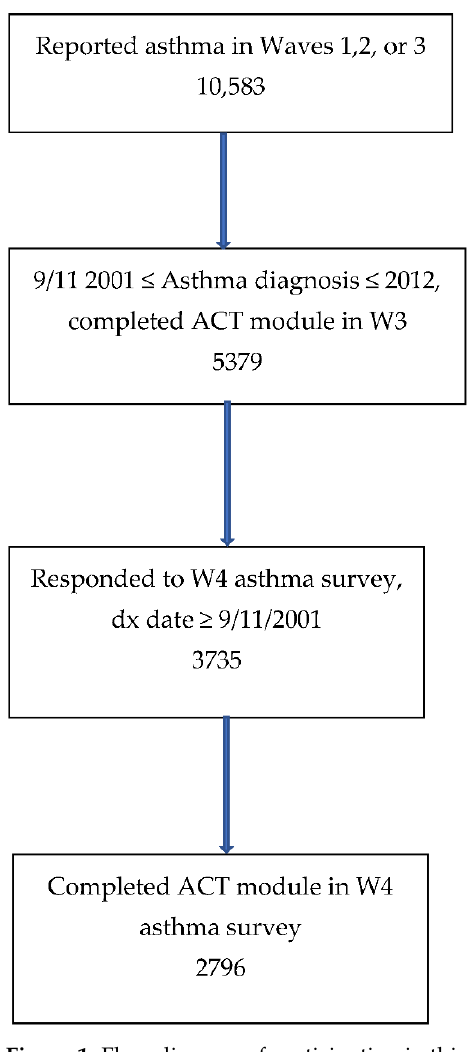
Figure 1. Flow diagram of participation in this study.